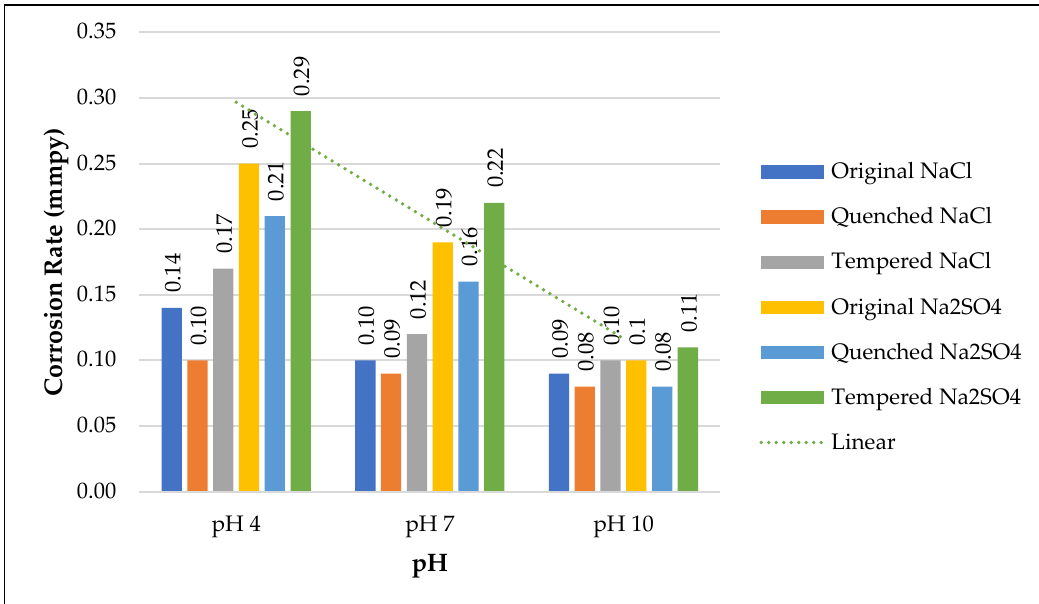
Figure 14. Effect of pH on corrosion rate of O, Q, and T.